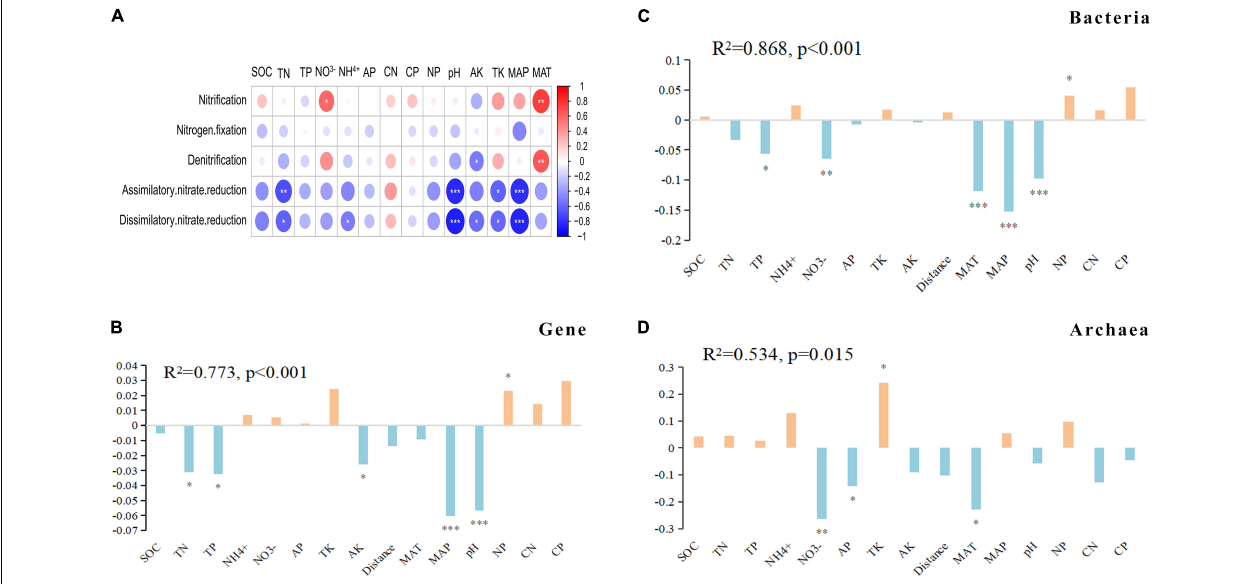
in the four counties were also these three ( Figure 4B ). More